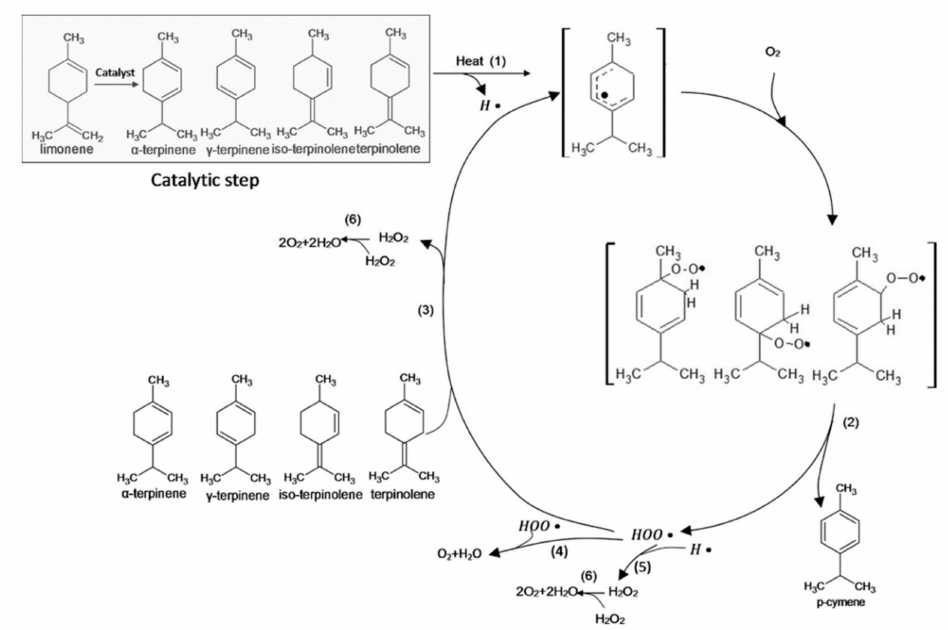
Figure 7. The reaction mechanism of the two-step conversion of limonene into p-cymene. Reproduced with permission from Makarouni et al. [38]. Copyright (2018) Elsevier